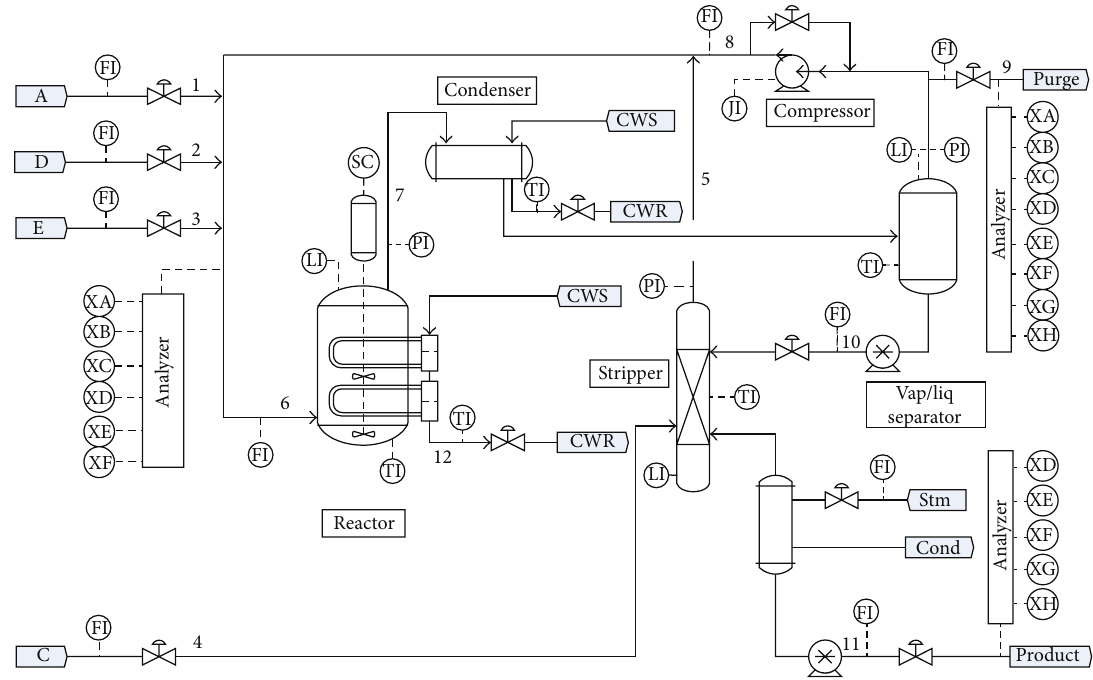
Figure 1: The Tennessee Eastman